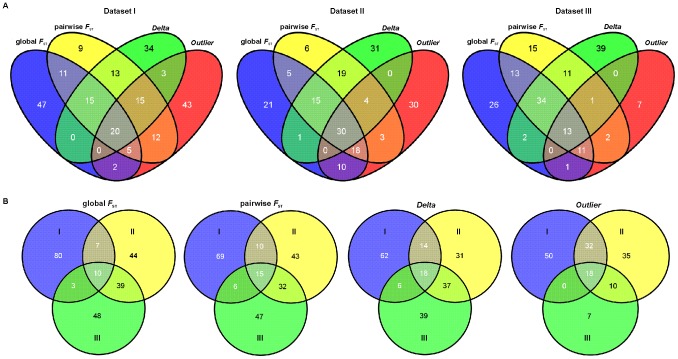
SNP overlap among different ranking approaches and population datasets.(A) Venn diagrams showing the extent of overlap among four approaches (global FST, pairwise FST, Delta and outlier) for three population datasets. (B) Venn diagrams showing the extent of overlap among three population datasets for four ranking approaches. For all SNP ranking methods the top 100 SNPs are presented, except for the outlier approach where 95 and 35 SNPs were identified as being under selection for dataset II and III, respectively.